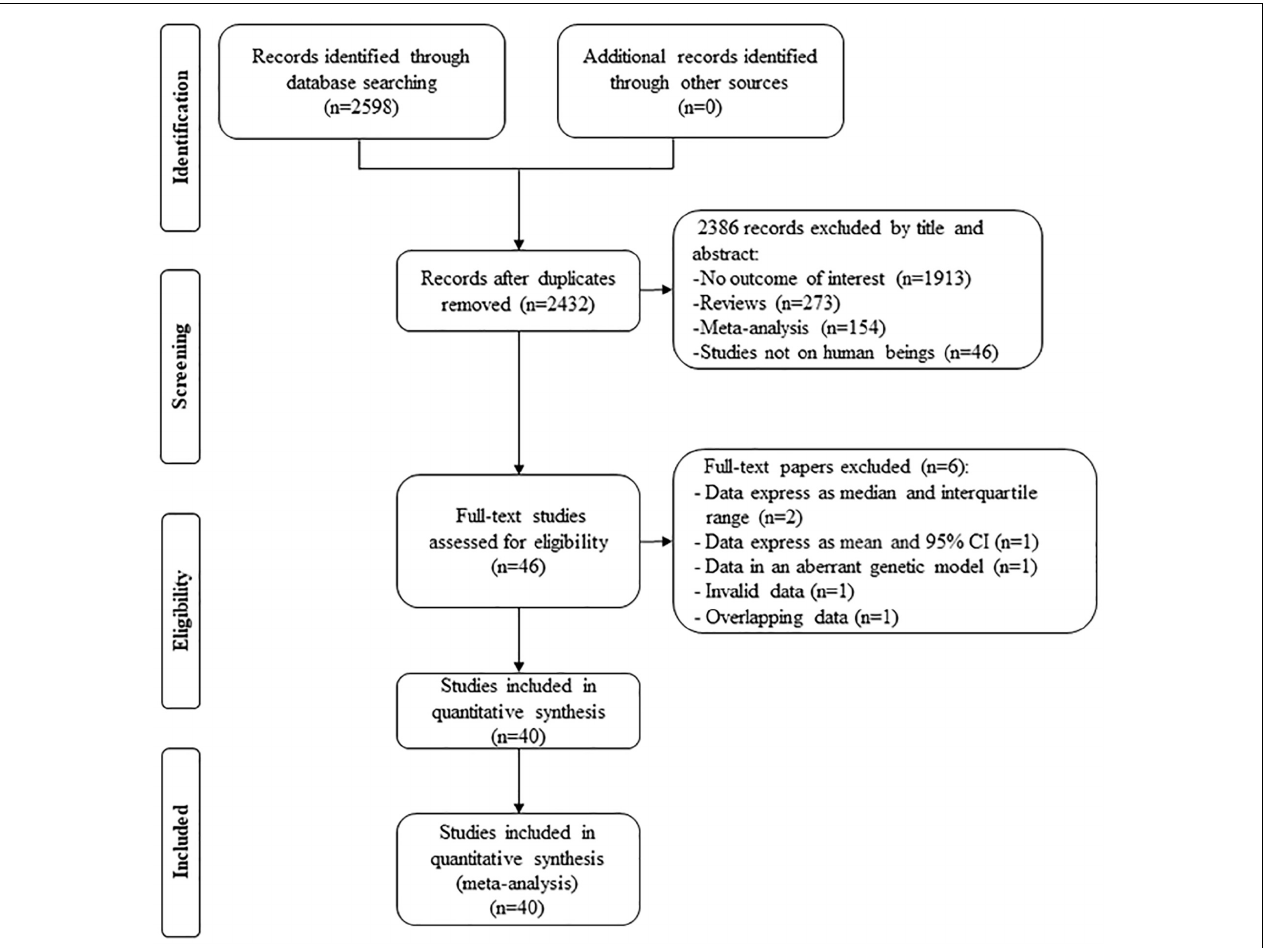
FIGURE 1 | Flow diagram of the articles selection